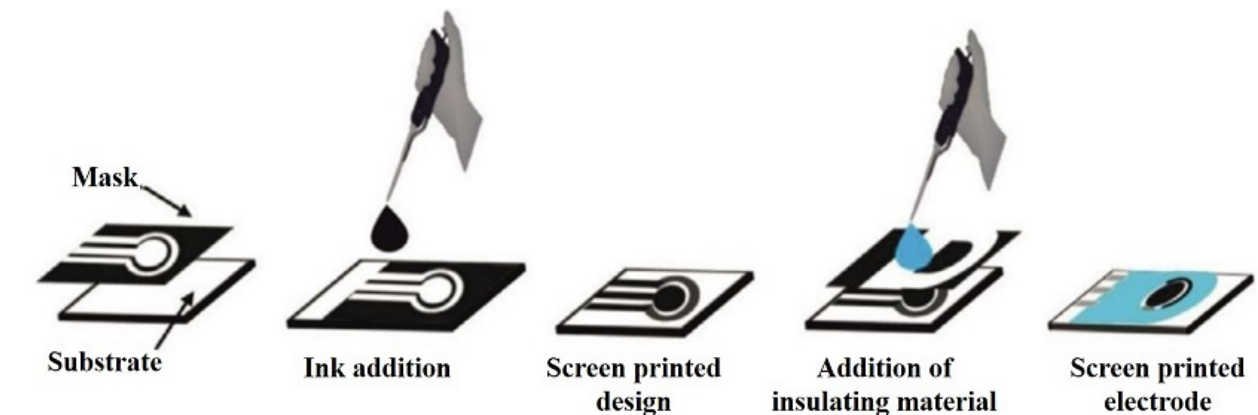
Figure 3. The construction process of SPEs (adapted and reprinted with permission from [2]).